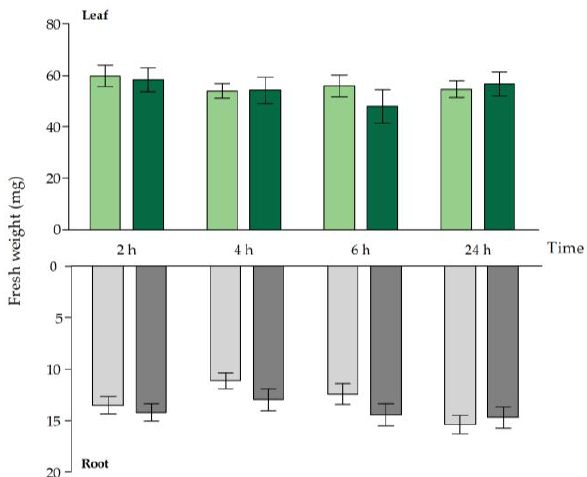
Figure 1. Rosette (green bars) and root (grey bars) fresh weight (mg) of Arabidopsis thaliana plants grown under control conditions (0 µ M CdSO4, light bars) or exposed to 5 µ M CdSO4 (dark bars) during 2 h, 4 h, 6 h and 24 h after 3 weeks of growth. For each time point, data represent the mean ± S.E. of eight biological independent replicates. No significant differences ( t -test: p < 0.05) were observed between control and exposed plants, within each time point. Table 1. Cadmium concentrations (mg kg −1 dry weight) in leaves and roots and the translocation factor (%) of Arabidopsis thaliana plants grown under control conditions (0 μM CdSO 4 ) or exposed to 5 μM CdSO 4 during 2 h, 4 h, 6 h, 24 h after 3 weeks of growth. For each time point, data represent the mean ± S.E. of four biological independent replicates. Significant differences ( t -test: p < 0.05) between control and exposed plants, within each time point, are marked in green. Significant differences over time are indicated with different letters (one-way ANOVA: p < 0.05). LOD: Cd levels below limit of detection (<10 ppb).